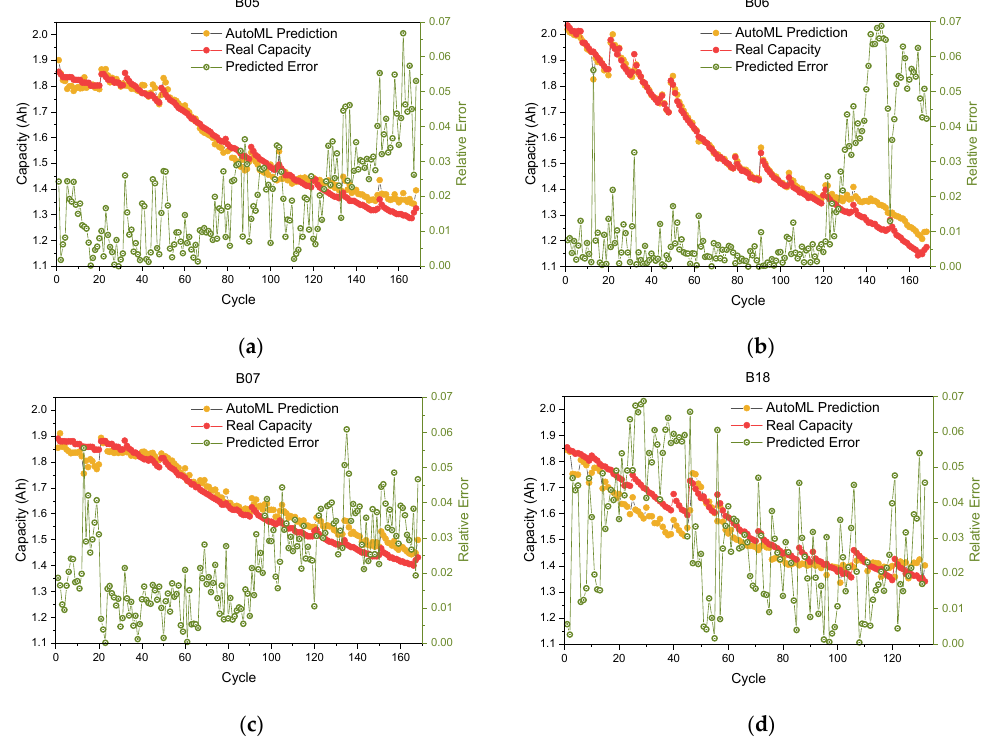
Figure 9. Capacity prediction results and errors of ( a ) B05, ( b ) B06, ( c ) B07, and ( d ) B18. Compared to the RMSE value in Table 4, the lowest prediction accuracy among the four batteries is B18. Although it is not as good as other batteries, the MAE of B18 is 0.0479, indicating the test accuracy rate reached more than 95%. According to the development requirements of batteries in EVs, the fault threshold is set to 80% of initial capacity, and the life value can also be predicted. The predicted error is 1 and 8 cycles for B06 and B18 respectively. All of the above illustrates that the proposed online prediction method has high accuracy and reliability. Table 4. Prediction results of four batteries. B05